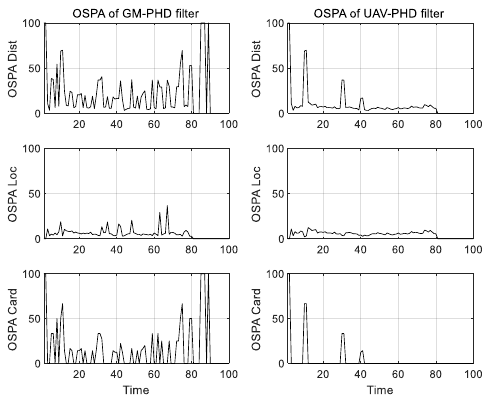
Figure 8. Comparison of OSPA (optimal subpattern assignment) performance of different methods.